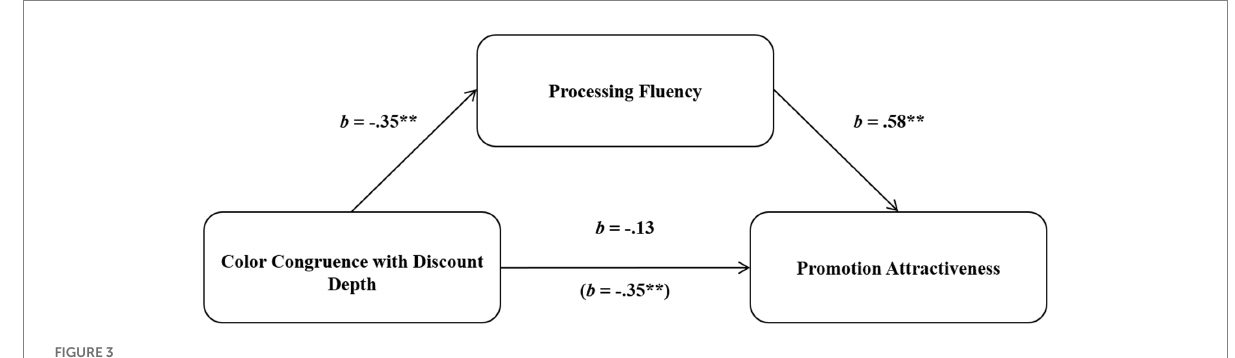
FIGURE 3 Research model and mediated moderation